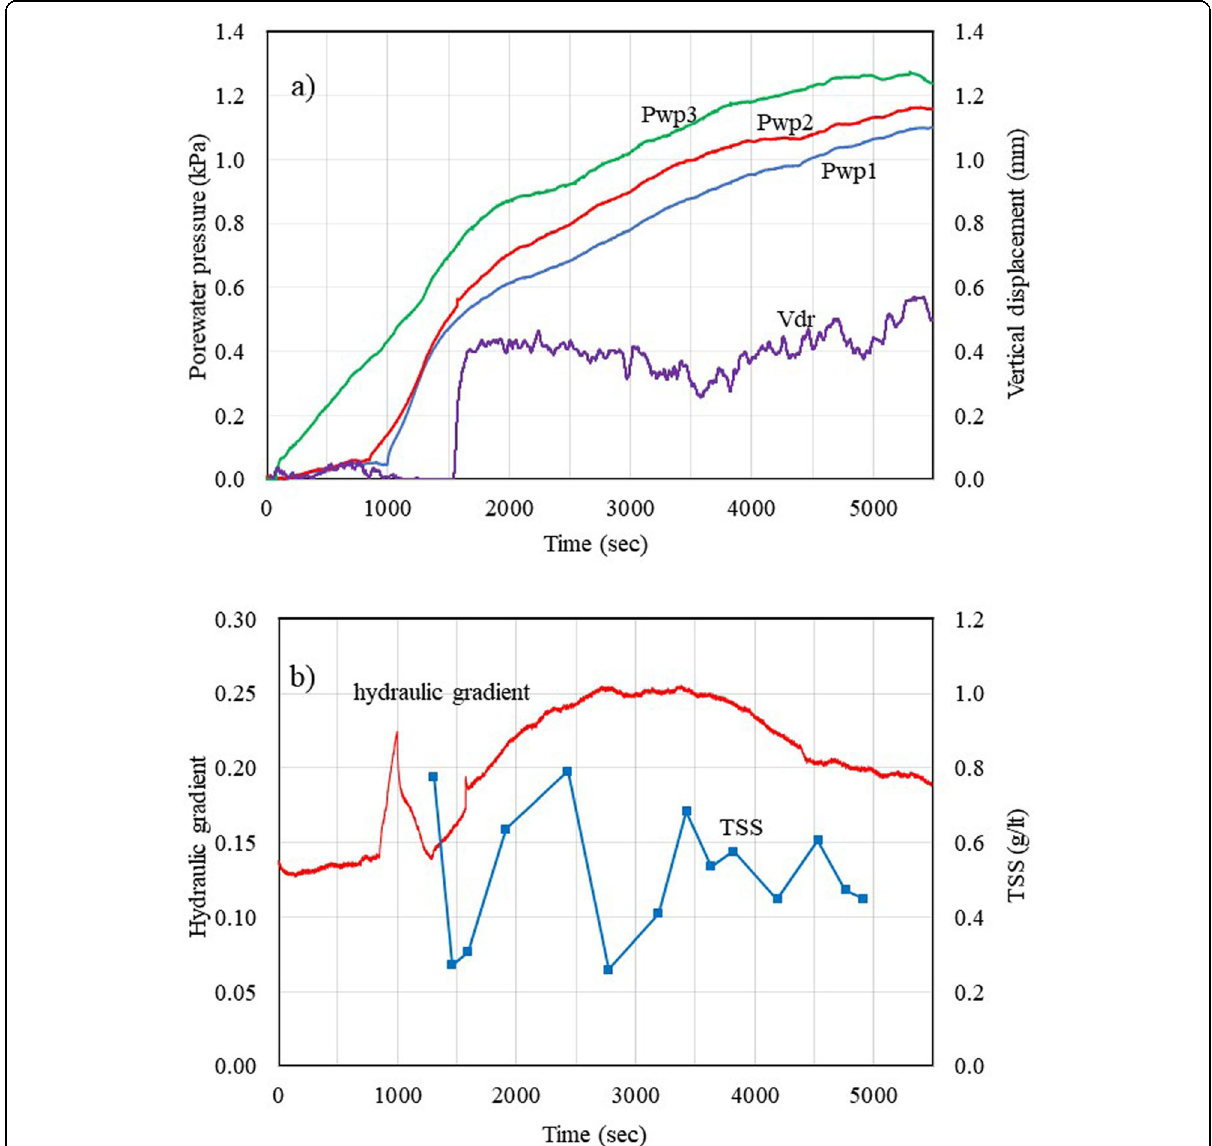
Fig. 12 Experiment results of experiment No. EXP 6NF of GIII sample. a Pore water pressure and vertical displacement curves b Hydraulic gradient and TSS